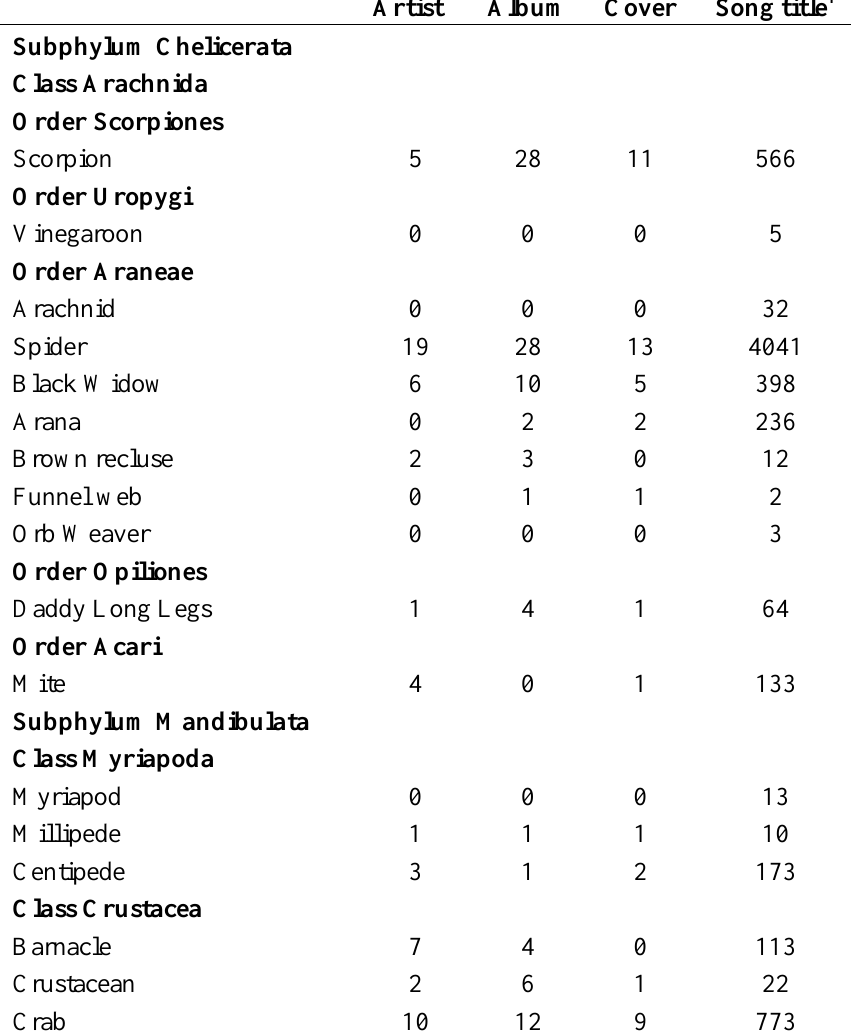
Table 1. Number of musical references to noninsect arthropod